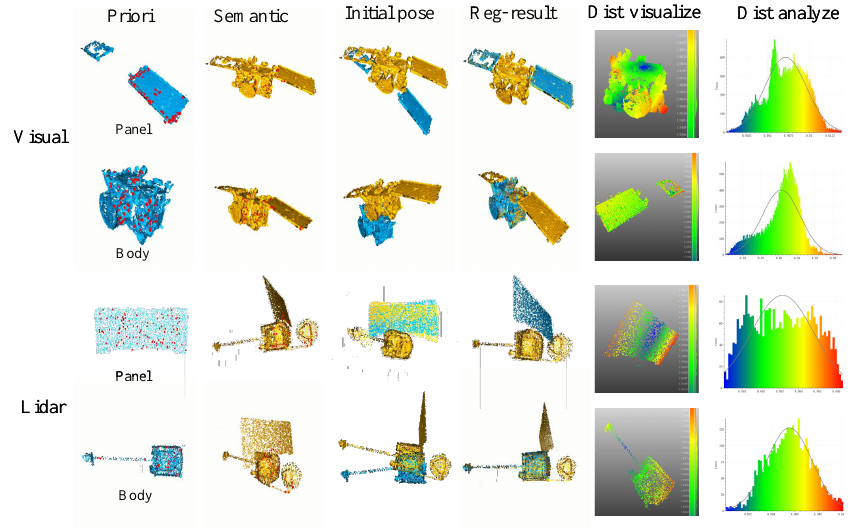
Figure 17. Partial prior point clouds registered with semantic point clouds generated by 3DSatNet.